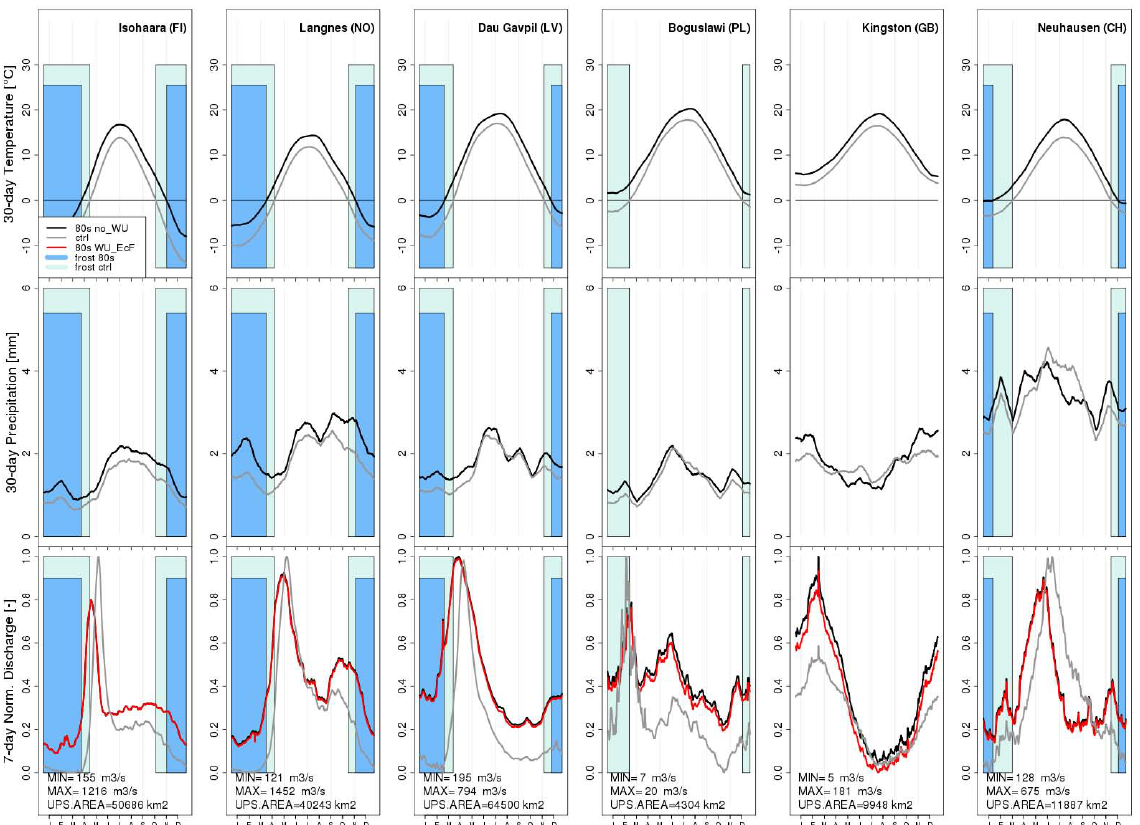
Fig. 5. Inter-annual dynamics in temperature (top row), precipitation (middle row) and 7 day average streamflow (bottom row) at a selection of stations (see Fig. 1) in the control period (light gray lines) and 2080s (black line). Temperature and precipitation reflect 30day upstream averages. The red line for streamflows (bottom row) reflects the scenario accounting for water use. Blue shaded areas indicate the frost season in both periods (control as light blue, 2080s as dark